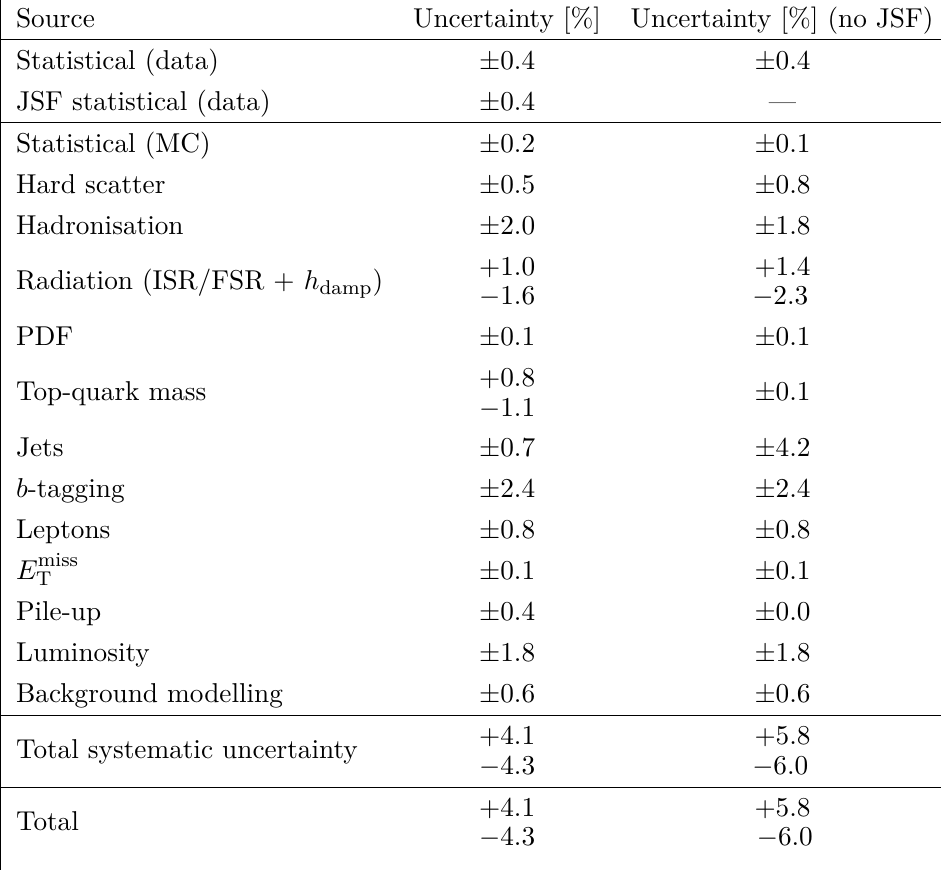
Table 2. Fractional uncertainty breakdown for the inclusive t ¯ t cross-section both with and without the JSF method